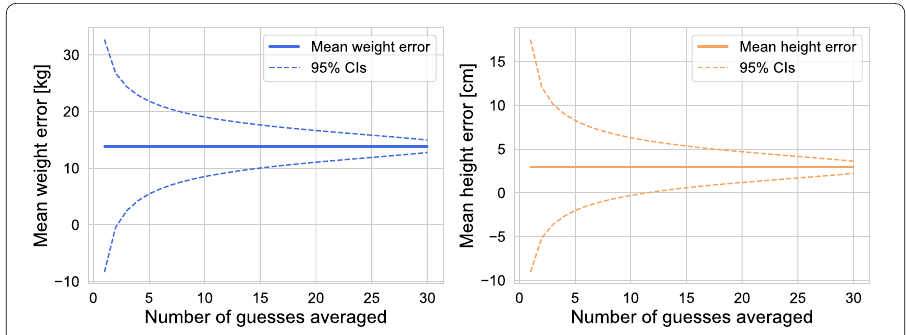
Figure 6 Convergence of mean error on all 1,682 images